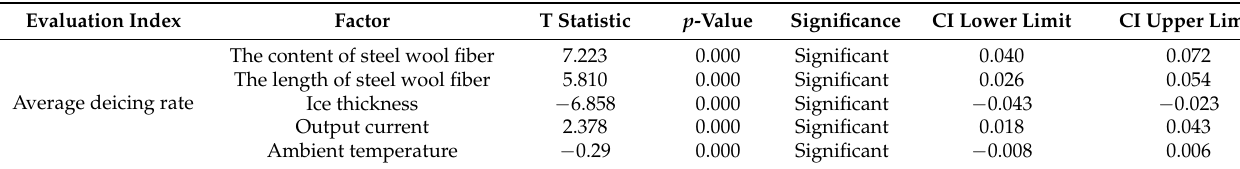
Table 5. t -test for